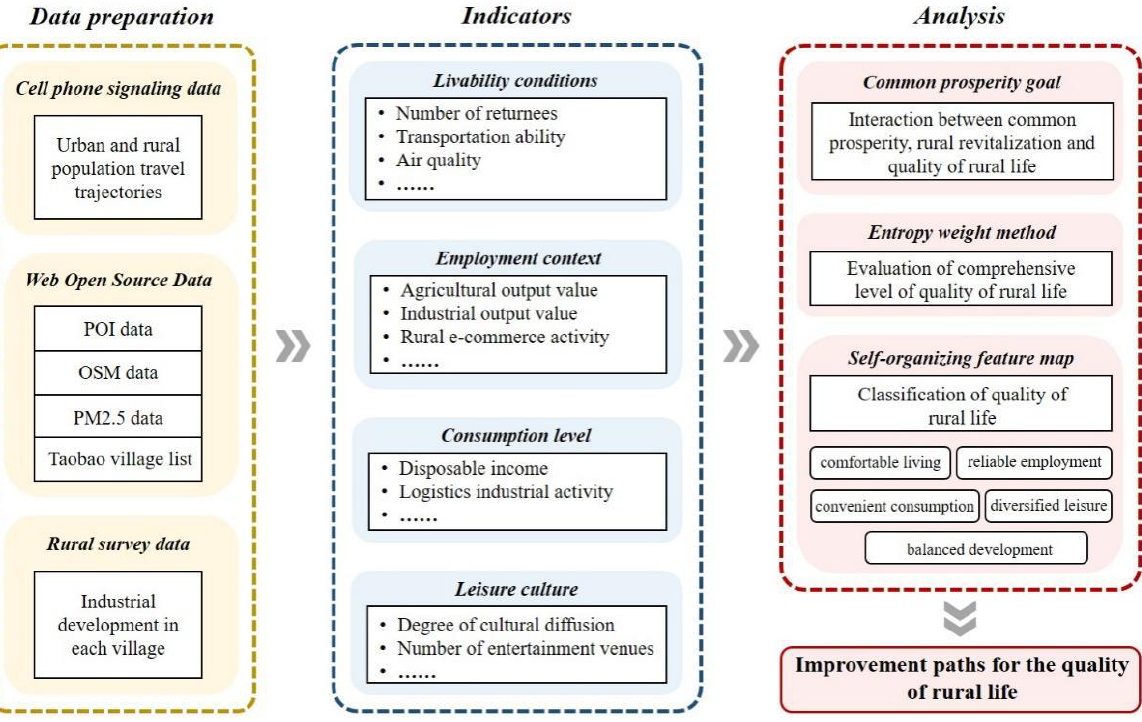
Figure 3. Research framework.